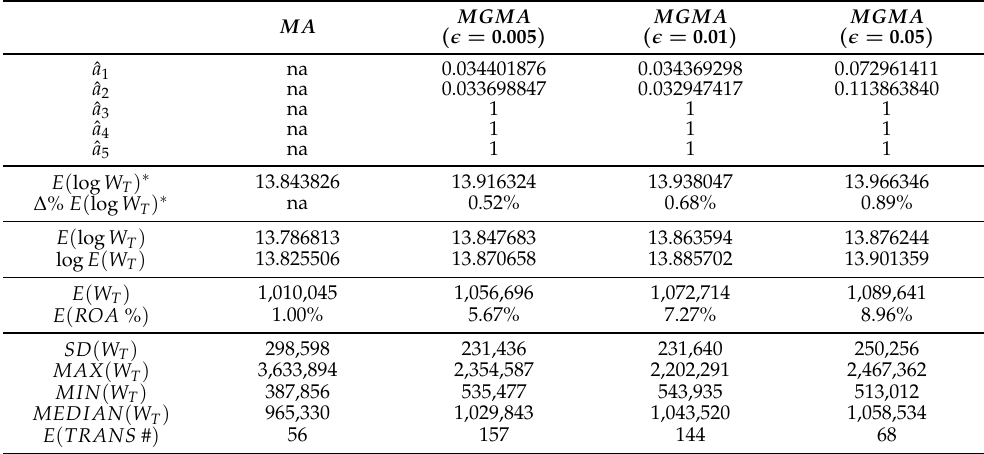
Table 5. MGMA strategy performance summary for scenario 2 on simulated two-asset portfolio (1000 run; s = 5; l =